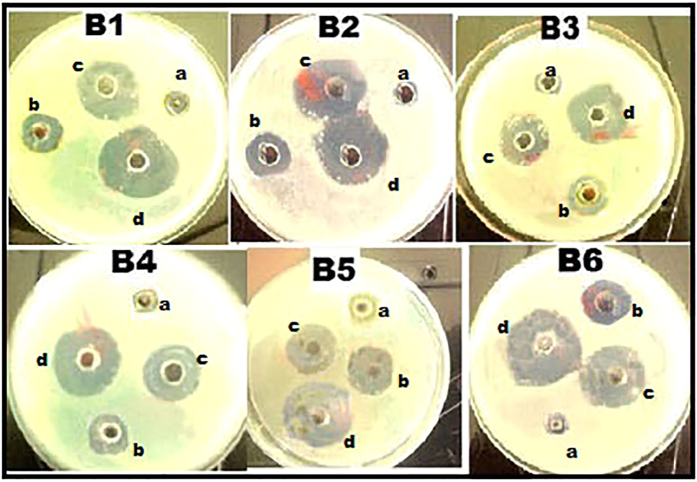
Petri plates showing the ZOI of SNPs, topical antibiotic and combinations against S. aureus.B1: Cefazolin; B2: Mupirocin; B3: Gentamycin; B4: Neomycin; B5: Tetracycline; B6: Vancomycin. a: Control; b: SNP; c: Topical antibiotic; d: SNP + Topical antibiotic.